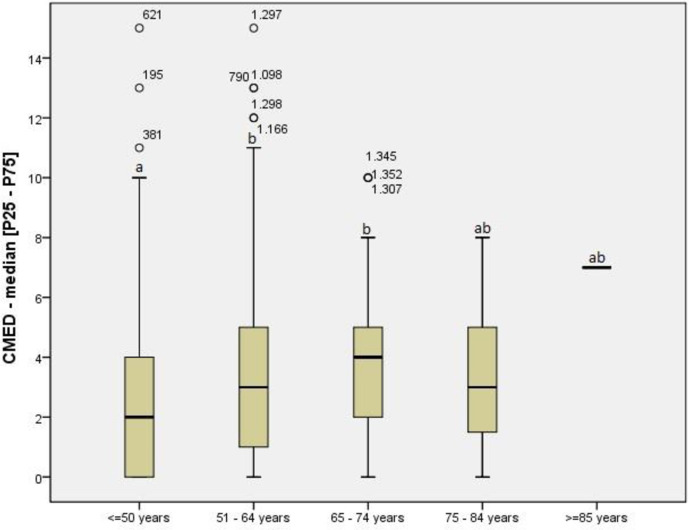
Comedications according to age group.Legend: CMED: comedications; P25-P75: interquartile range (percentiles 25th - 75th); Kruskal-Wallis test (Dunn post hoc): p≤0.0001. Significance set at 5% for all analysis. Different letters (ab) indicate Statistical significance.